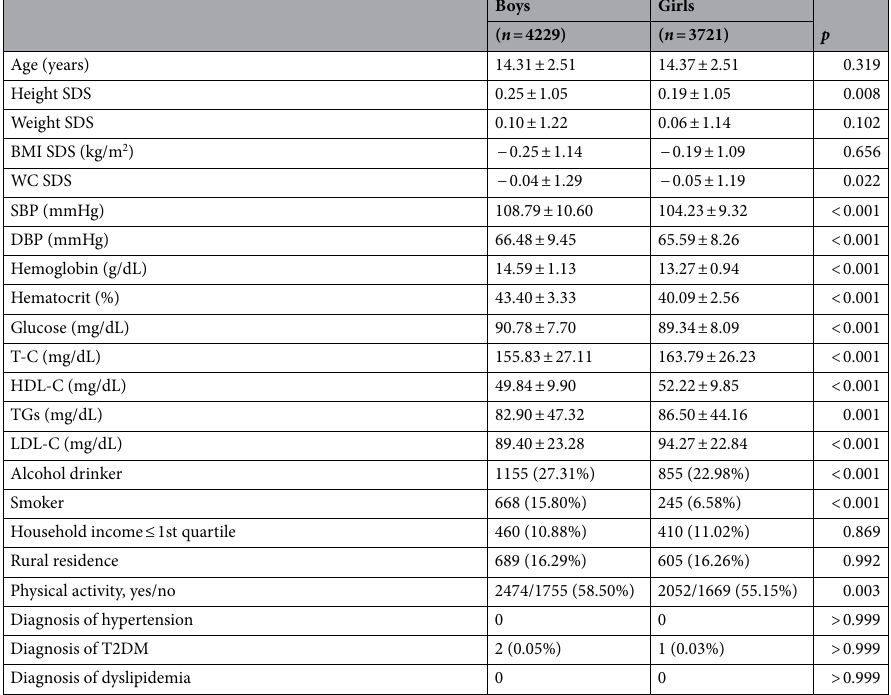
Table 1. Clinical characteristics of the study population ( n = 7950). SDS standard deviation score; WC waist circumference; BMI body mass index; SBP systolic blood pressure; DBP diastolic blood pressure; T-C total cholesterol; HDL-C high-density lipoprotein cholesterol; TGs triglycerides; LDL-C low-density lipoprotein cholesterol; T2DM type 2 diabetes